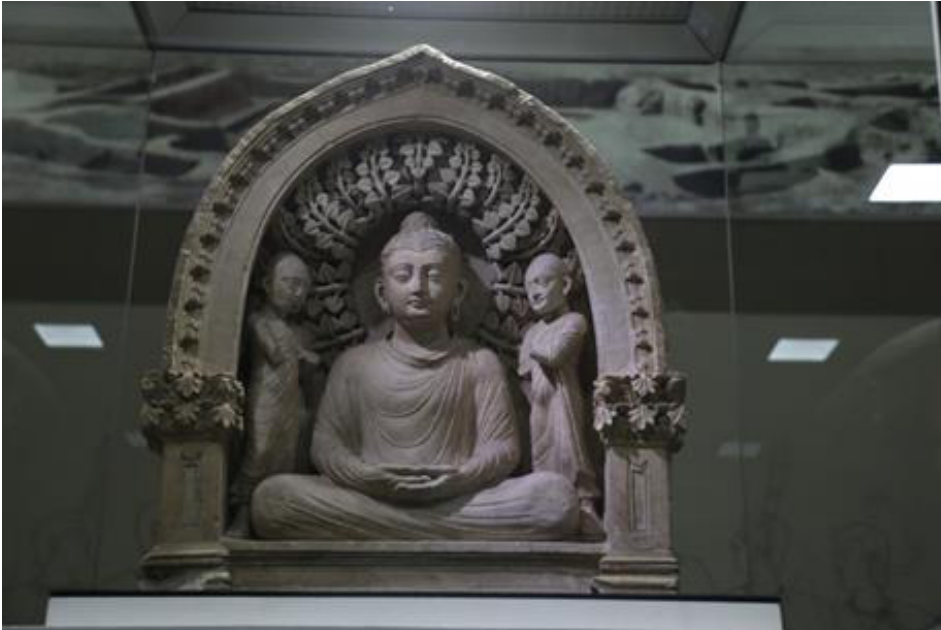
Figure 5. “Buddha” statue in the State Muse um of the History of Uzbekistan in Tashkent. The statue is standing on a pedestal in a display case with glass walls. Access to the statue is possible by opening the side wall on the right side (Figure 6). The statue is too heavy to be easily removed from the display case. During the planning stage, it was estimated that the front glass of the display case was located at a distance from the statue ’ s surface allowing for a 3D scanner to be placed inside. There was also free access to the right side of the statue after opening the display case. The panes on the left side and on the back of the statue were too close to the object for a scanner to be placed inside. The Artec Eva scanner was able to scan the statue ’ s front with satisfactory accuracy, but there was a risk of not being able to scan deep, narrow grooves and internal fragments of the statue due to the dimensions and working distance of the scanner. Additionally, scanning through the glass might have introduced some errors, despite being possible for structured light scanners. Finally, after consultations with the museum, it was decided to 3D scan the statue ’ s front from the inside of the display case in order to ensure good-quality archiving of the shape of the statue’s most valuable parts. In the case of other parts, as of quite simple shape and texture, they were scanned through the glass. Then, the scanning stage was executed. Preparation of the scanning site, including opening the display case, took 10 min. The scanning process itself took 45 min. As a result, 20 partial scans were collected in total: 15 scans of the statue’s front carried out directly and 5 scans carried out through the glass. After another 15 min, the display case was restored to its original condition. Data processing leading to the high-quality textured 3D mesh model took 5.3 h. The dissemination model, satisfactory in terms of quality and performance ratio, was obtained after 1.2 h.